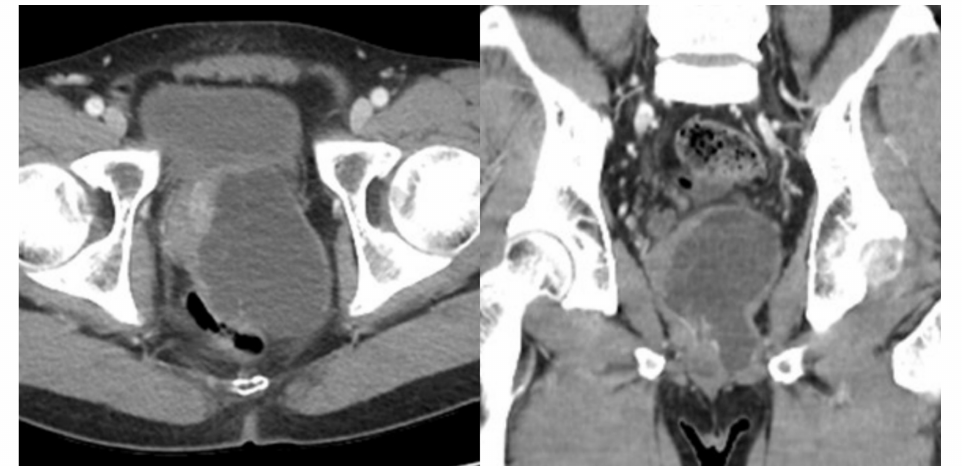
Figure 3. Abdominal CT showed an 8.0 × 6.5 × 9.0 cm-sized, lobulated cystic lesion with multiple thin septa in the left prostate without solid